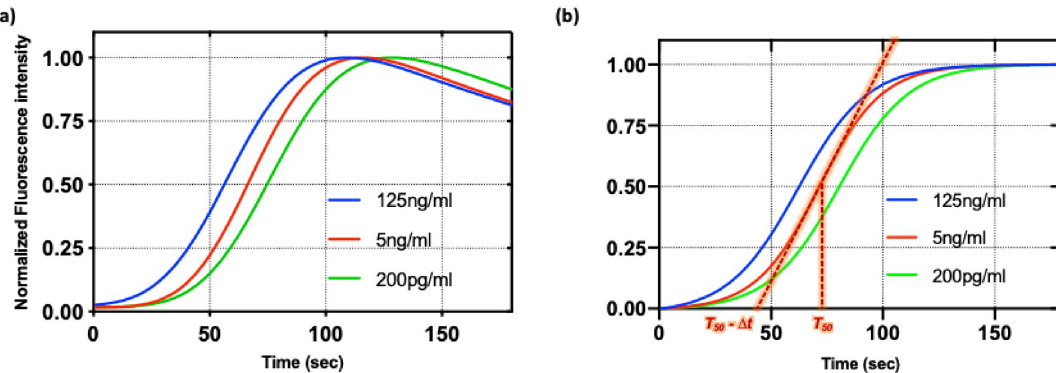
Figure 3. Fluorescence intensity profile when photooxidation amplifies the fluorescence in the mixture of resorufin, ADHP and hydrogen peroxide ( a ) normalized fluorescence intensity profile interpolated with quenching model when initial resorufin concentration was varied ( b ) normalized intensity profile with autocatalysis model whose fitting parameters were extracted from quenching model. Red dotted line is tangential at the half-maximum time, T 50